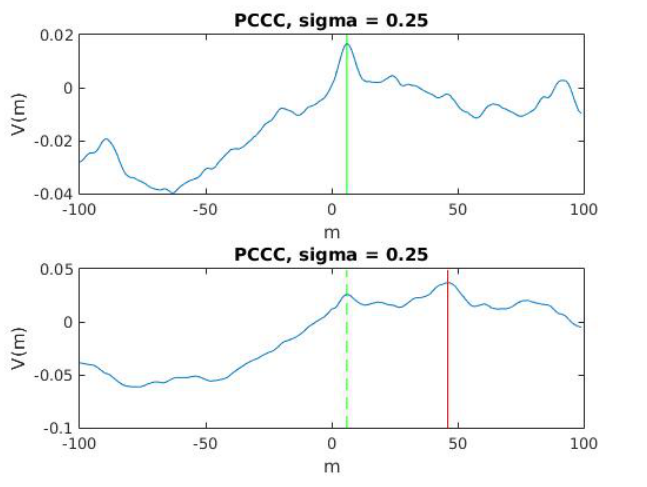
Figure 2. PCC of different windows. In upper row, the global maxima reveal the correct time offset. The lower row has its time offset revealed as a local